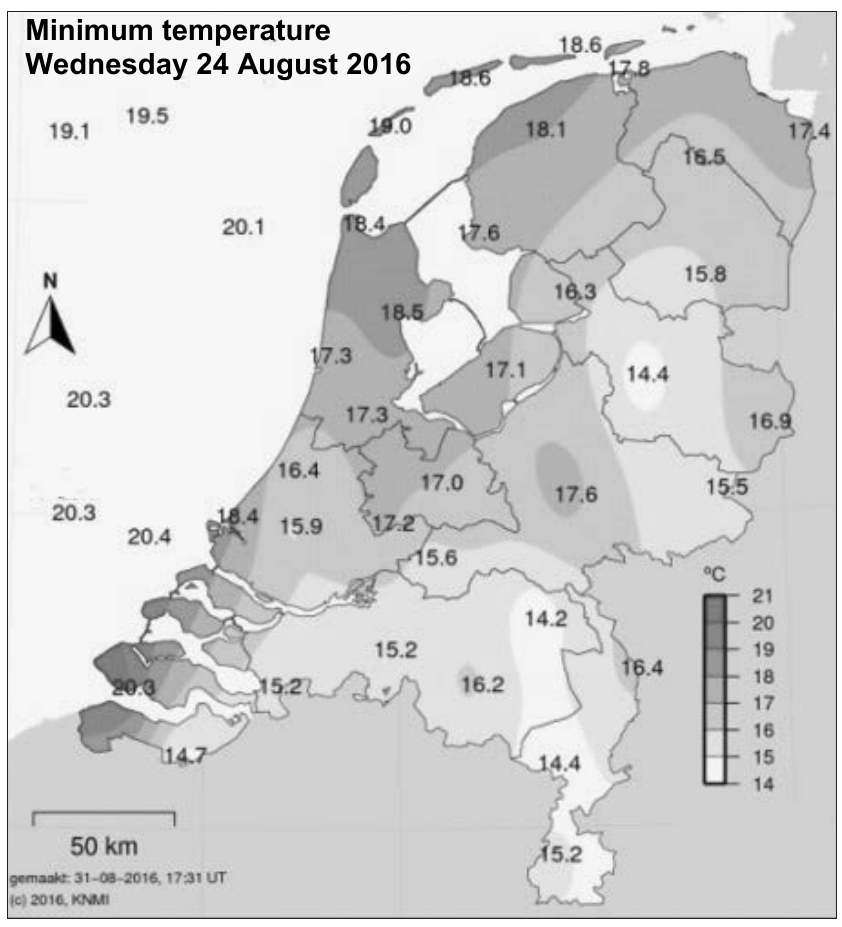
Figure 5: Temperature map of The Netherlands